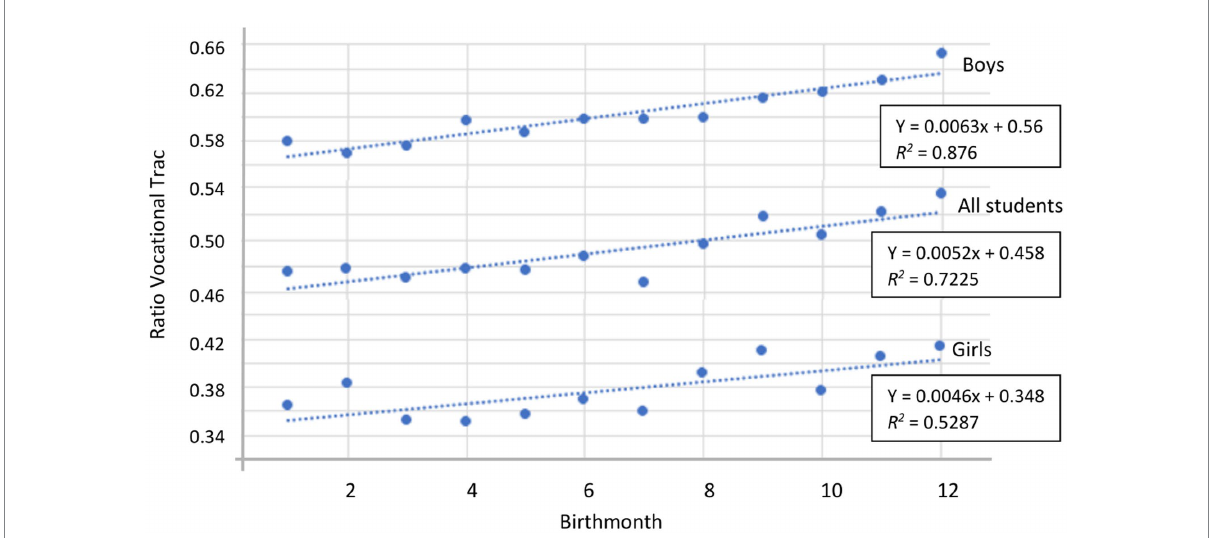
FIGURE 1 Regression lines with R 2 for boys (upper line), all students (middle line) and girls (bottom line) showing ratio of students choosing vocational tracks ( y -axis) vs. birth month ( x -axis). Ratios exceeding 0.5 indicate more students applying for vocational